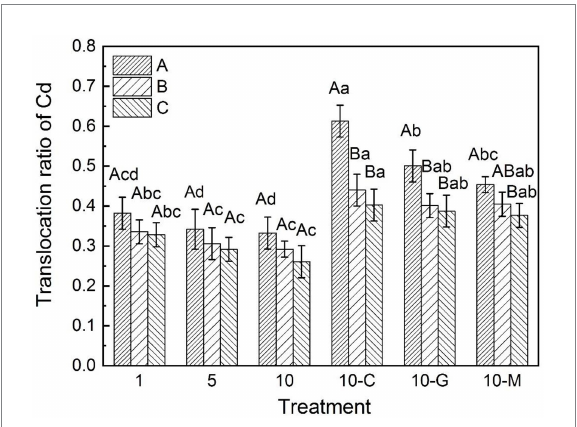
FIGURE 3 Translocation ratio of cadmium in S. sudanense in different soil types. The values shown are the mean ± SE ( n = 3). Differences sampled indicated by capital letter are between soil types, and by lower-case letter are Cd/exudates related. The same letters among specific treatments are not significantly different according to Duncan’s (0.05). A, B, and C represent sandy, loamy, and clayey, respectivly. Treatments: 1, 1 mg kg − 1 cadmium ion- contaminated soil; 5, 5 mg kg − 1 cadmium ion-contaminated soil; 10, 10 mg kg − 1 cadmium ion-contaminated soil; 10-C, 10 mg kg − 1 cadmium ion-contaminated soil with the addition of 20 ml citric acid solution at 50 mmol L − 1 ; 10-G, 10 mg kg − 1 cadmium ion- contaminated soil with the addition of 20 ml glycine solution at 50 mmol L − 1 ; 10-M, 10 mg kg − 1 cadmium ion-contaminated soil with the addition of 20 ml maltose solution at 50 mmol L − 1 .